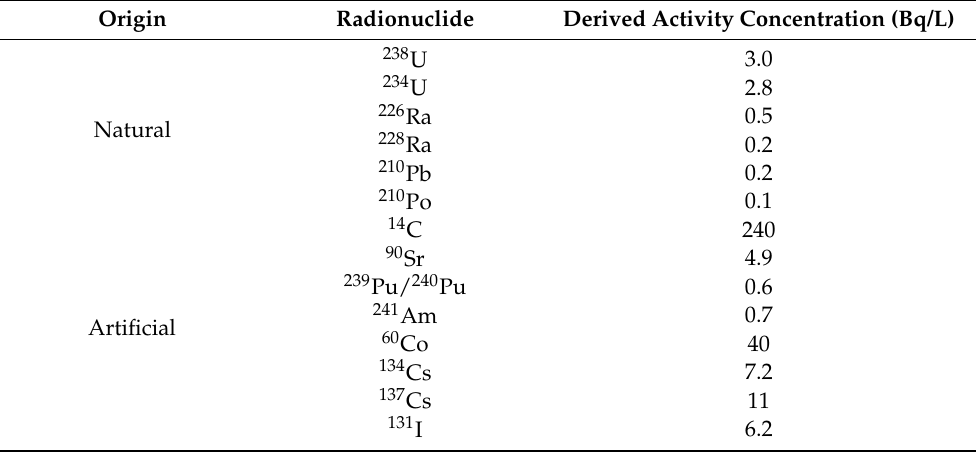
Table 2. Derived activity concentration of radionuclides in drinking water ([36], Annex 3).